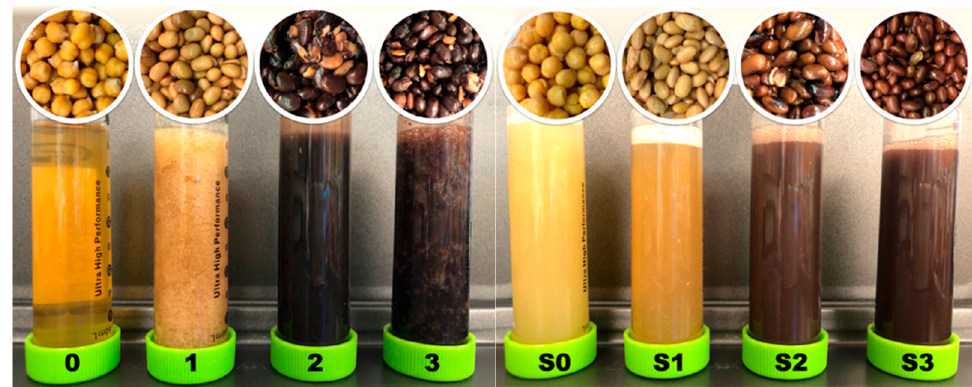
Figure 3. AQ samples separated from chickpea and soybeans. L–R, seed images: seed remaining after cooking and separation of the AQ, w/o presoaking AQ samples (0–3) and w/presoaking AQ samples (S0–S3); L–R, tube images, w/o presoaking AQ samples (0–3) and w/presoaking AQ samples (S0–S3). The densities of the AQ from the pre-soaked untreated (0–3) and the pre-soaked group (S0–S3) were 1.053–1.065 and 1.015–1.036, respectively, and there was a